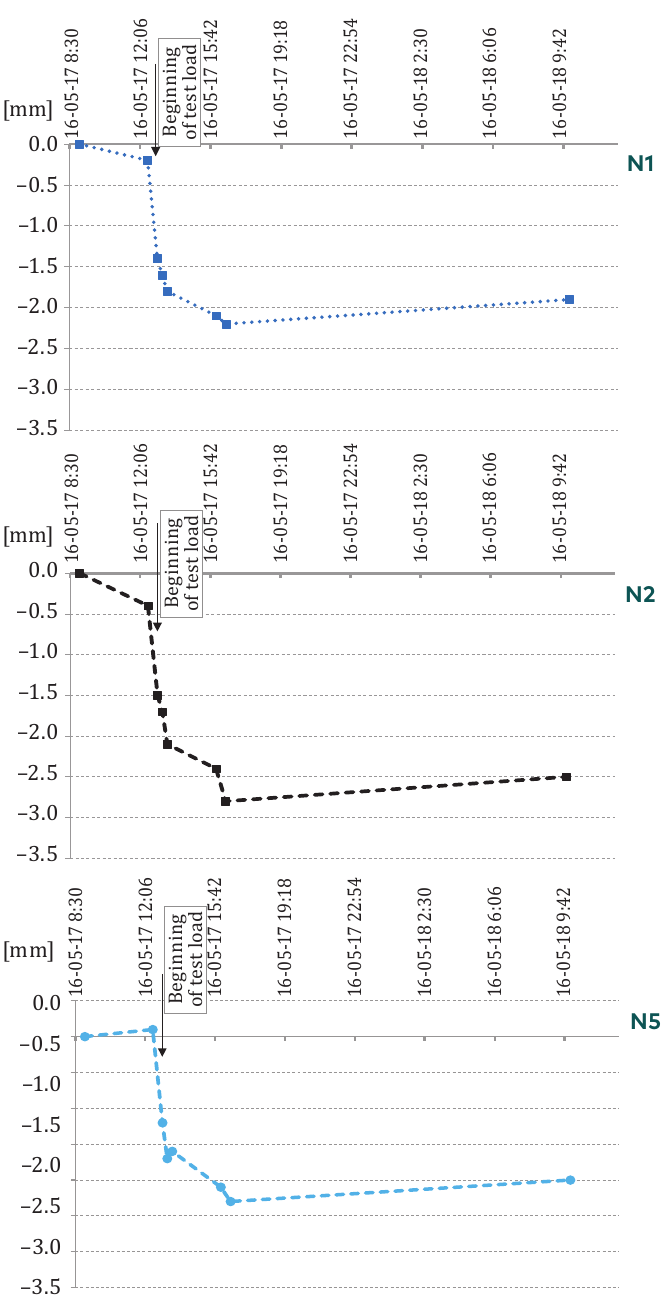
Figure 7. Vertical displacements (in mm) of control benchmarks N1, N2, N5 within 24 hours from starting test